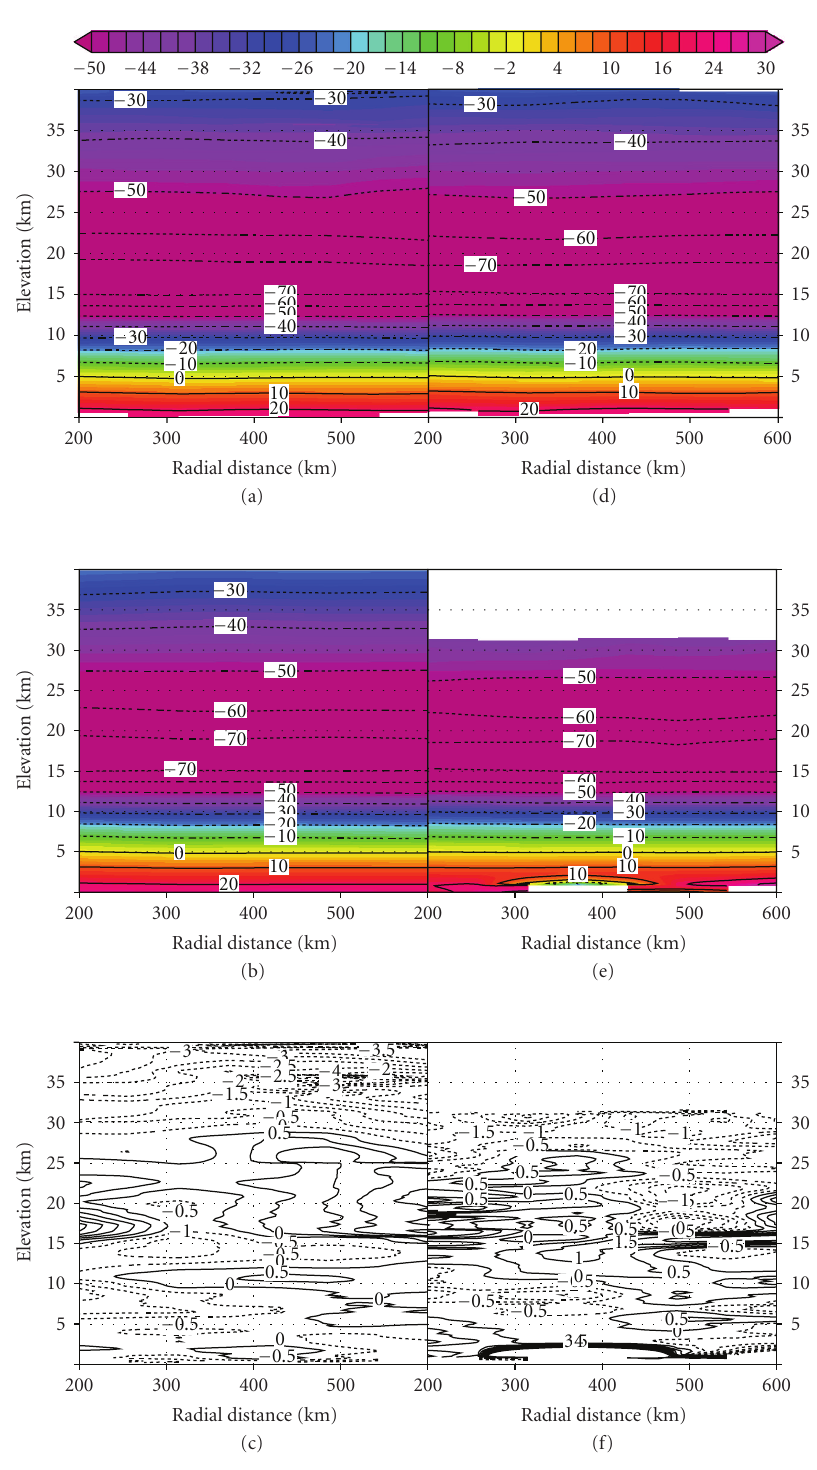
Figure 4: Radial mean temperature ( ◦ C) intercomparisons for observations colocated with both global analysis profiles and radiosondes. The x -axis is radial distance (km) while the y -axis is vertical elevation (km). (a) Radial mean temperatures from GPS RO observations with available colocated global analysis profiles. (b) Radial mean temperatures from colocated global analysis profiles. (c) Radial mean di ff erences between colocated observations and global analysis profiles. (d) Radial mean temperatures from GPS RO observations with available colocated radiosonde observations. (e) Radial mean temperatures from colocated radiosonde observations. (f) Radial mean di ff erences between colocated observations and radiosonde observations. White regions in (a), (b), (d), and (e) represent where either the observations or colocated profiles are missing